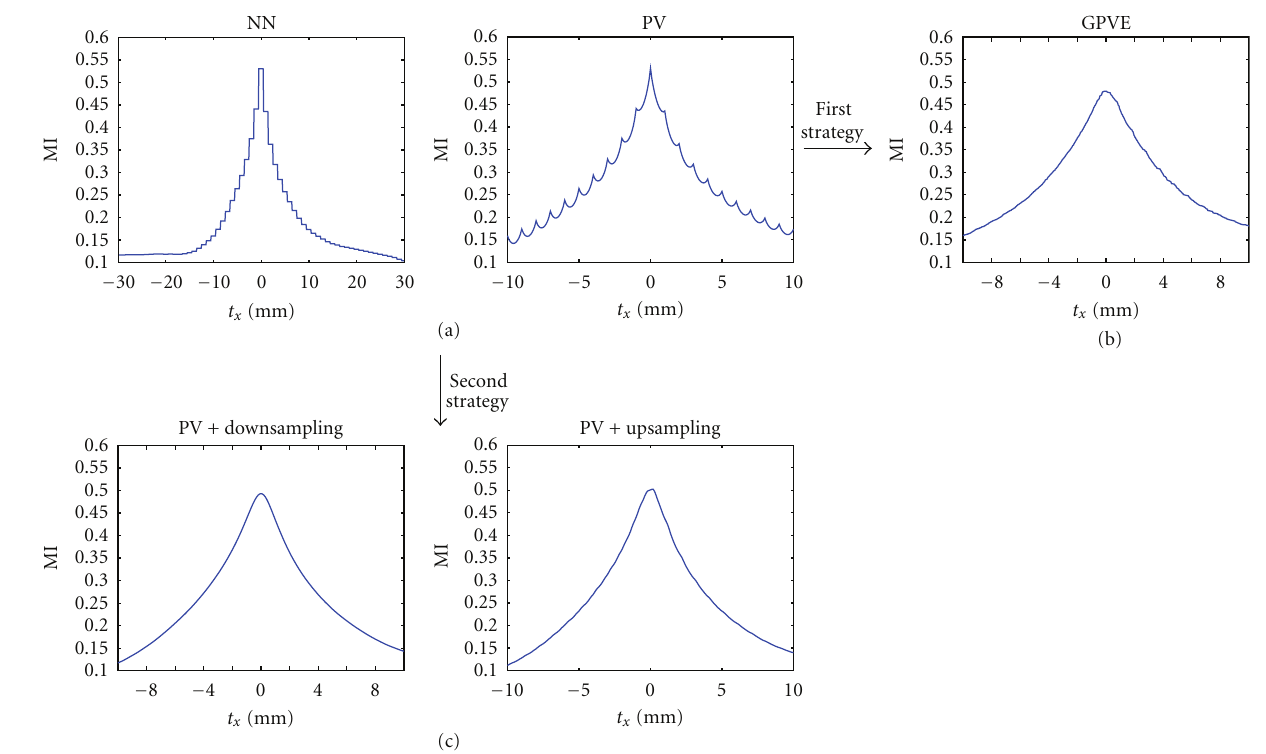
Figure 2: Typical MI translational pattern obtained by using di ff erent interpolation methods and strategies. Translational results for the PV method are shown in the range ± 10 mm to illustrate the interpolation artifacts. Translational results for the GPVE, PV + downsampling and PV + upsampling methods are shown in the range ± 10 mm for comparison of the pattern obtained against the PV curve. When the second strategy is applied, the downsampling produced a new voxel dimensions = 1 . 11 mm × 1 . 11mm × 1 . 11mm, and the upsampling a new voxel dimensions = 0 . 89 mm × 0 . 89 mm × 0 . 89 mm.